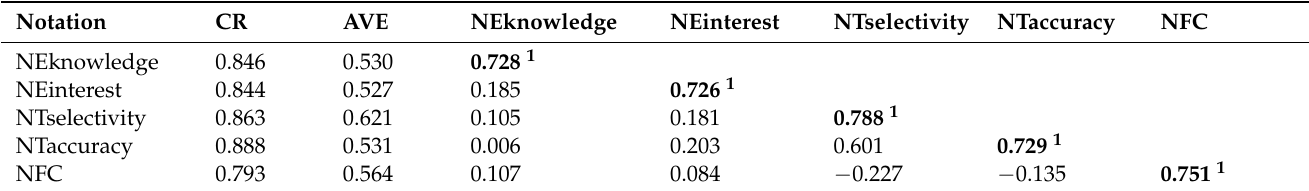
Table 4. Results of validity and reliability analysis of the model.